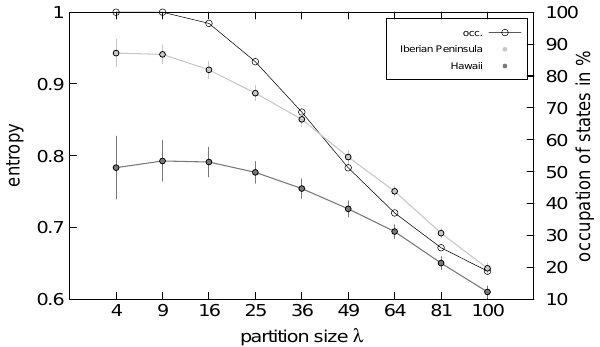
Fig. 9. Entropy of the regional climate systems of Hawaii (dark grey) and the Iberian Peninsula (light grey). From partition size λ = 16 full occupation of the states of the transition matrix cannot be